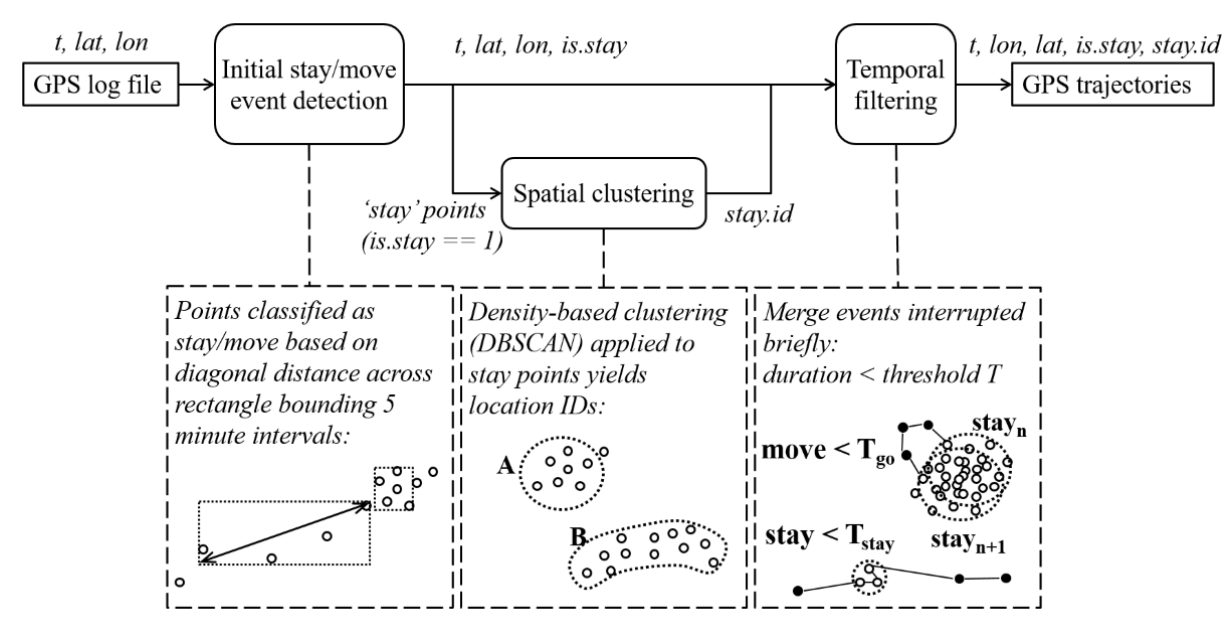
Figure 1. Overview of the trajectory extraction algorithm. DBSCAN: density-based spatial clustering of applications with noise; GPS: global positioning